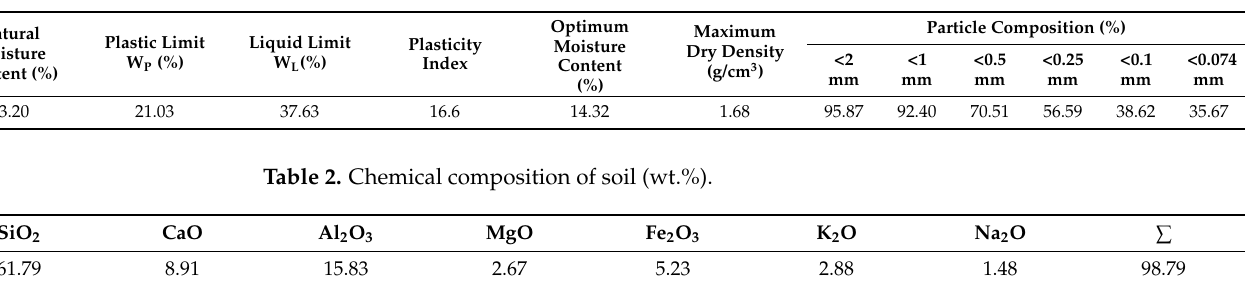
Table 1. Physical characteristics of soil.